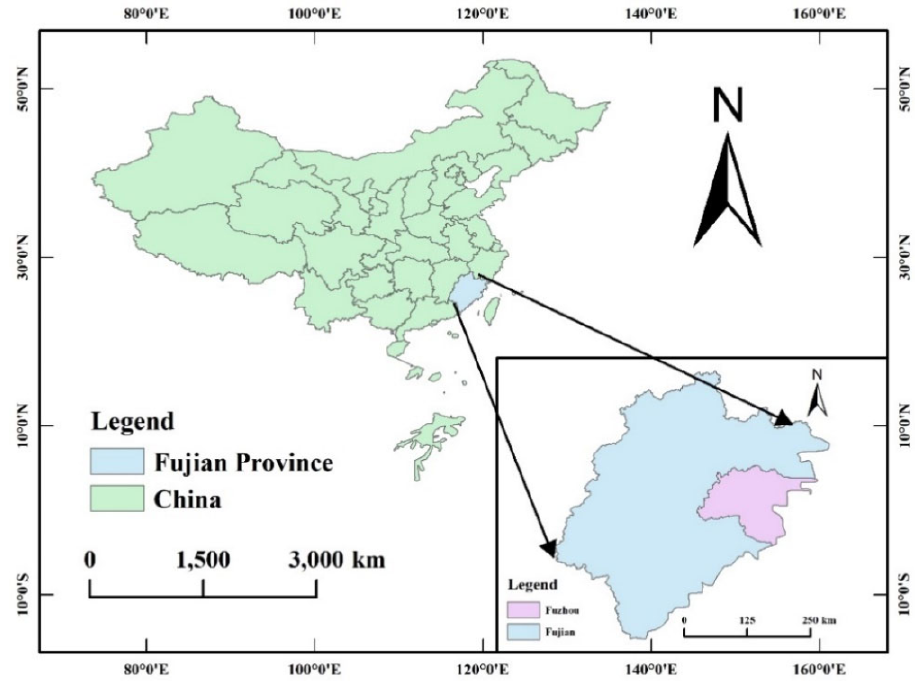
Figure 1. The location of this study